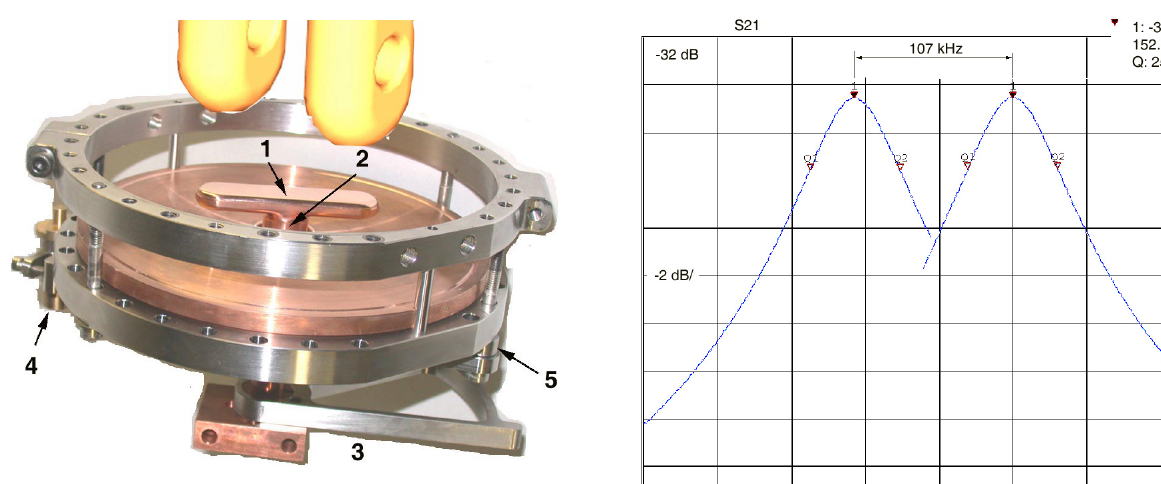
of the 2-QWR 21